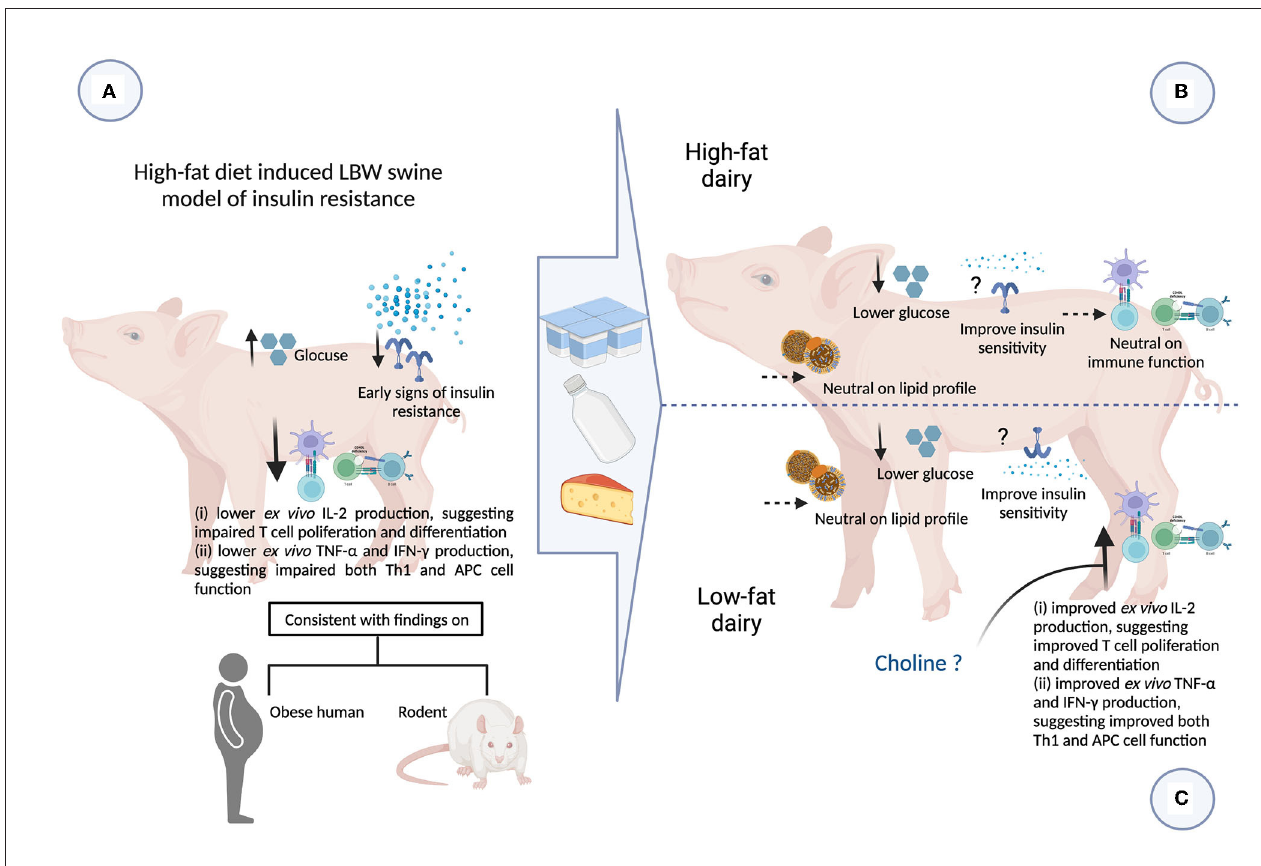
FIGURE 5 | Summary of impact of consuming 3 servings high- and low-fat dairy products on obesity-related cardiometabolic and immune perturbations (figure created with BioRender). APC, antigen presenting cell; CHF, control high-fat diet; HFDairy, high-fat dairy diet; IFN- γ , interferon-gamma; IL, interleukin; LBW, low birthweight; LDL-C, low-density lipoprotein cholesterol; LFDairy, low-fat dairy diet; NBW, normal birthweight; TC, total cholesterol; Th, T helper cell; TG, triglycerides; TNF- α , tumor necrosis factor-alpha. (A) LBW piglets fed with a high-fat diet (LBW-CHF) developed elevated fasting glucose concentrations and early signs of insulin resistance. Following ex vivo immune cell stimulation, poor IL-2, TNF- α and IFN- γ productions was observed suggesting impaired T and APC cell function compared to NBW control groups. This is also consistent with findings in individuals with obesity and rodent models. (B) Feeding high-fat dairy products (LBW-HFDairy) improved (lowered) fasting glucose while had minor effects on immune function compared to LBW-CHF. (C) Feeding low-fat dairy products (LBW-LFDairy) also improved (lowered) fasting glucose while significantly improved IL-2, TNF- α , and IFN- γ productions following ex vivo stimulation, suggesting improved T and